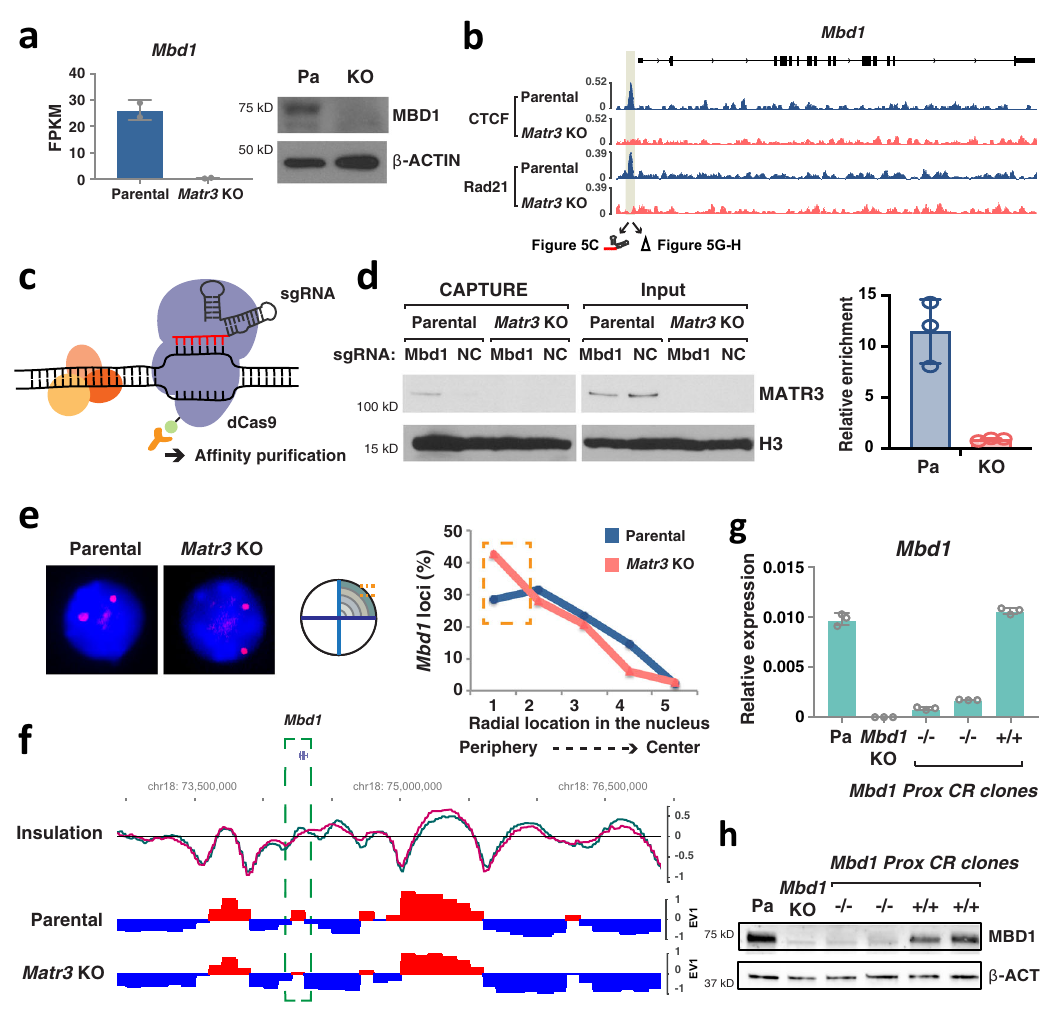
Fig. 5 Matr3 loss alters chromatin contacts to the nuclear structure. a Reduced expression level of Mbd1 was revealed by RNA-seq from two independent experiments and Western blot. β -actin was used for a Western blotting control. b Chromatin occupancy of CTCF and Rad21 in parental and Matr3 KO cells near Mbd1 locus is shown. c CAPTURE experiment 43 was performed using sgRNAs directed to a putative cis-regulatory element near Mbd1 which is occupied by CTCF and cohesin, and an adjacent upstream, as a negative control (NC) (Figs. 5b and S4b). d Puri fi cation of biotinylated dCas9 and Western blot indicated that Matr3 interacted with the putative element (Mbd1) but not with the upstream control (NC). Relative enrichment of Matr3 protein at the putative element to the upstream control was quanti fi ed from three independent experiments. e Radial location of the Mbd1 gene was observed by 3D DNA FISH. For quanti fi cation, the nuclear radius was divided into fi ve shells and the number of signals in each shell was counted. The graph is the result of 2 – 3 independent experiments and the change was signi fi cant under a two-sided t test ( p = 0.006; Cohen ’ s d = 0.32). f Snapshot of Hi-C data at the Mbd1 locus showing compartments in parental and Matr3 KO cells and the difference in insulation score (parental in green and Matr3 KO in magenta). g , h Deletion of CTCF/cohesin binding region (shaded box in Fig. 5b) by CRISPR/Cas9 reduced Mbd1 expression. RNA ( g ) and protein ( h ) levels were examined by RT- PCR ( n = 3) and Western blotting, and compared to Mbd1 KO cells. β -actin was used for a Western blot control. Data were the result of 2 – 3 independent experiments and error bars represent mean ± s.d. Source data are provided as a Source Data fi le. typical for genes within inactive chromatin. Consistent with this, (Figs. 5c and S4b – d). Af fi nity puri fi cation of biotinylated dCas9 the active A compartment containing the Mbd1 gene body was targeted to the CTCF/Rad21-bound regulatory element, but not weakened in the global interaction analysis by Hi-C (Fig. 5f). the control region, revealed signi fi cant enrichment of Matr3 CTCF/cohesin-mediated chromatin organization is required for protein (Fig. 5d). This fi nding, together with the absence of proper regulation of gene expression 9,10 . In fact, CTCF/cohesin- CTCF/cohesin occupancy and diminished expression of Mbd1 in Matr3 KO cells, strongly suggests that the presence of Matr3 at occupied region upstream of Mbd1 was located near a loop this region is required for the chromatin association of CTCF and anchor, and the insulation became weaker in Matr3 KO cells cohesin to coordinate Mbd1 transcription. (Fig. S4a). Therefore, we examined the region where CTCF/ To detect the relative position of the Mbd1 gene locus inside cohesin occupancy was perturbed in Matr3 KO cells (Fig. 5b). the nucleus, we employed fl uorescence in situ hybridization Using CRISPR/Cas9-mediated deletion, we generated cells with (FISH) (Fig. 5e). In Matr3 KO cells, Mbd1 loci appeared to be deletion of the entire Mbd1 gene and cells in which the CTCF/ more frequently situated closer to the nuclear periphery, which is cohesin binding region near Mbd1 was speci fi cally removed. NATURE COMMUNICATIONS| (2021) 12:6241